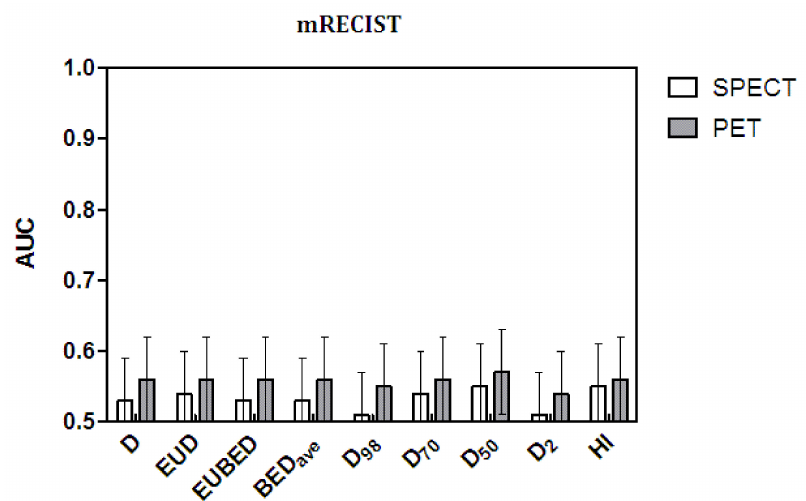
Figure 3. The AUC values for the ROC of 99m Tc-SPECT and 90 Y-PET returned with the mRECIST